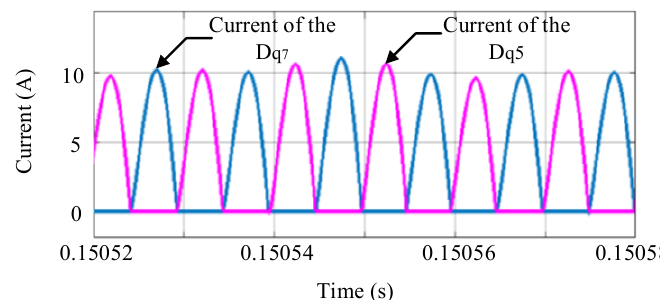
Figure 21. Current of D q5 and D q7 .